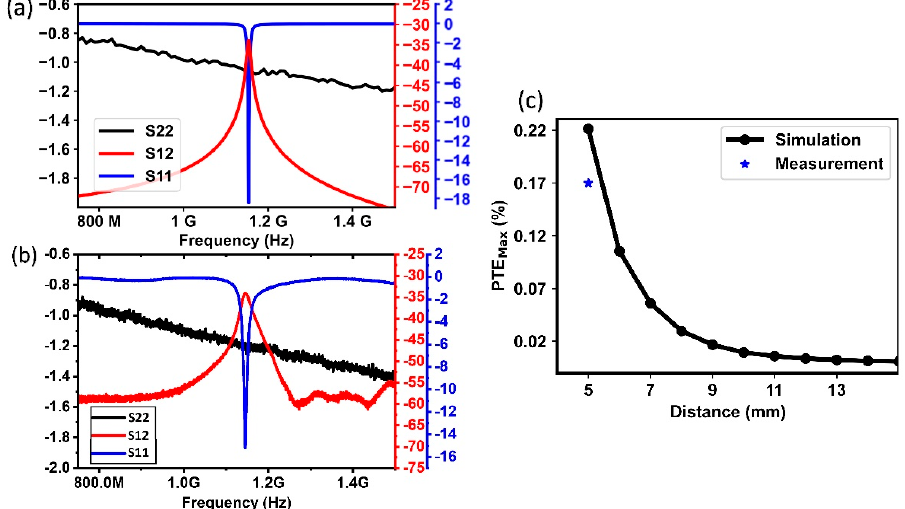
Figure 7. ( a ) Simulated and ( b ) measured S 11 , S 12 , S 22 parameters of a 2-coil inductive link through air with 5 mm Tx–Rx separation. ( c ) Simulated and measured PTE max as a function of Tx–Rx distance.